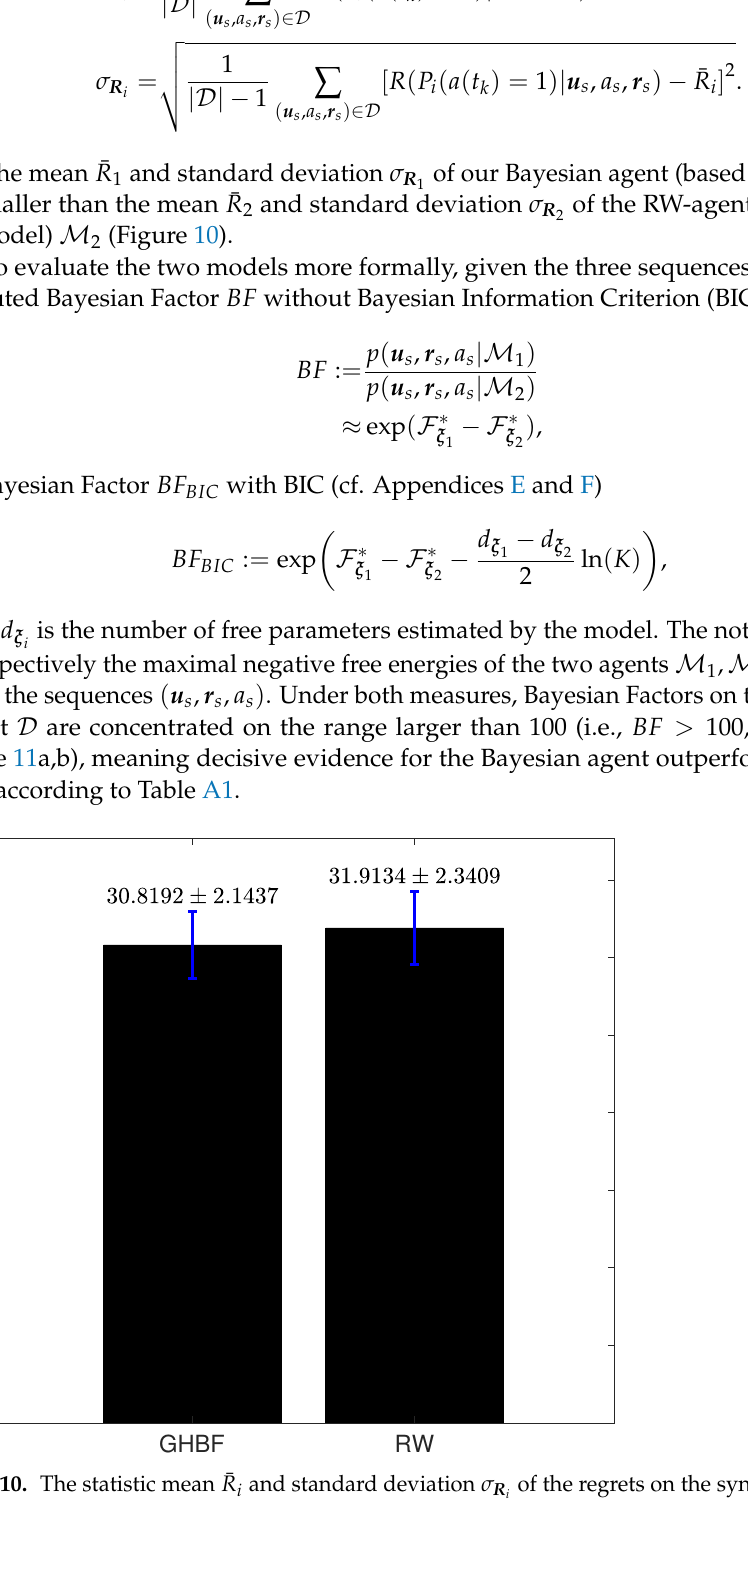
of the regrets on the synthetic dataset i